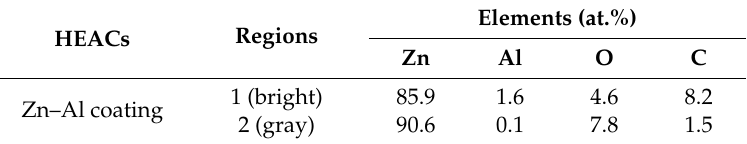
Table 1. Chemical compositions of the Zn–Al coating according to EDS analyses.